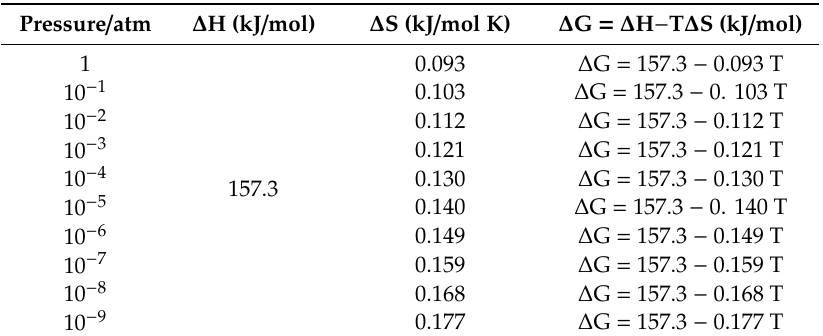
Table 3. Free energy, enthalpy and entropy of the reaction CuO = Cu + 1 / 2 O 2 at di ff erent partial pressure of